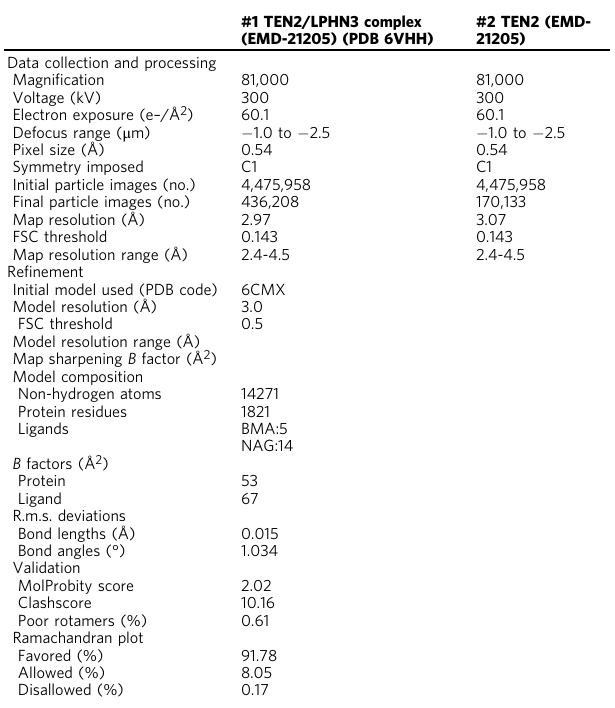
Table 1 Cryo-EM data collection, re fi nement and validation